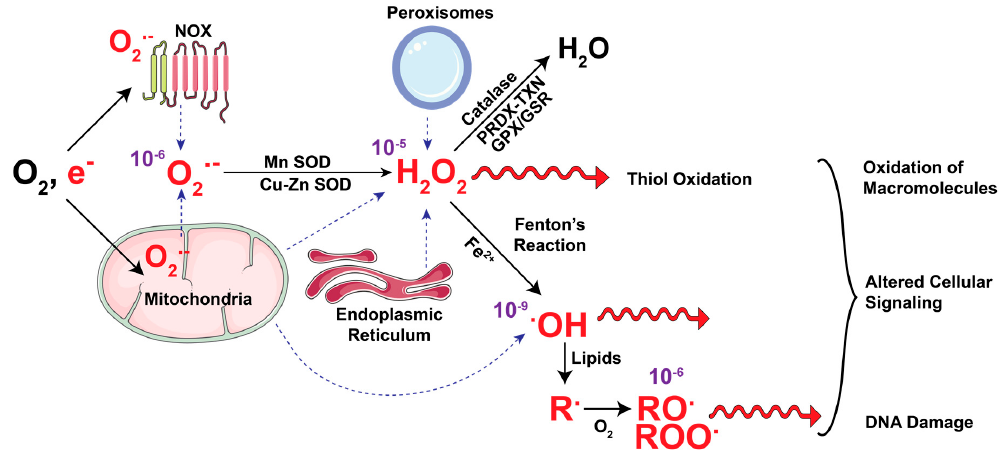
Figure 1. ROS axis: generation and detoxification of common reactive oxygen species. The mitochondrial electron transport chain (ETC) and NADPH oxidases (NOX) take up oxygen (O 2 ) and generate superoxide (O 2 • − ) which is dismutated in the mitochondria, peroxisome and endoplasmic reticulum by Copper-Zinc (Cu-Zn) and Manganese (Mn) superoxide dismutases (SOD) to generate hydrogen peroxide (H 2 O 2 ). H 2 O 2 is converted into water by simultaneous oxidation of the catalytic cysteine residues of the peroxiredoxin (PRDX) and thioredoxin (TXN) proteins. H 2 O 2 is also actively nullified by the glutathione peroxidase-glutathione reductase (GPX-GSR) that recycles oxidized glutathione (GSSG, not shown) back to its reduced form (GSH, not shown). Mitochondrial O 2 • − radicals release Fe + ions by damaging ETC complexes. In presence of Fe 2+ ions H 2 O 2 converts to